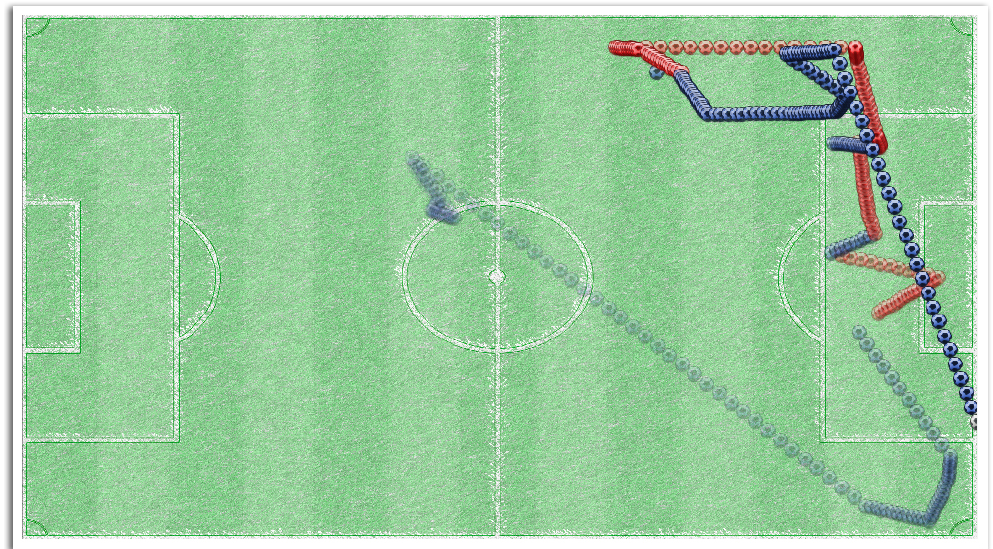
Figure 11. This visualization shows us the trajectory of the ball over a move. The color of the ball represents which team was in possession of the ball. The more transparent the ball is, the more movement happened in the beginning of the move. This move was detected by searching for similar moves where the semantically-meaningful feature straightness was very low. Disorganization is characteristic. Although the red team gets possession of the ball several times, it is not able to clear the situation. This serves as a strong indicator for a coach to take action.